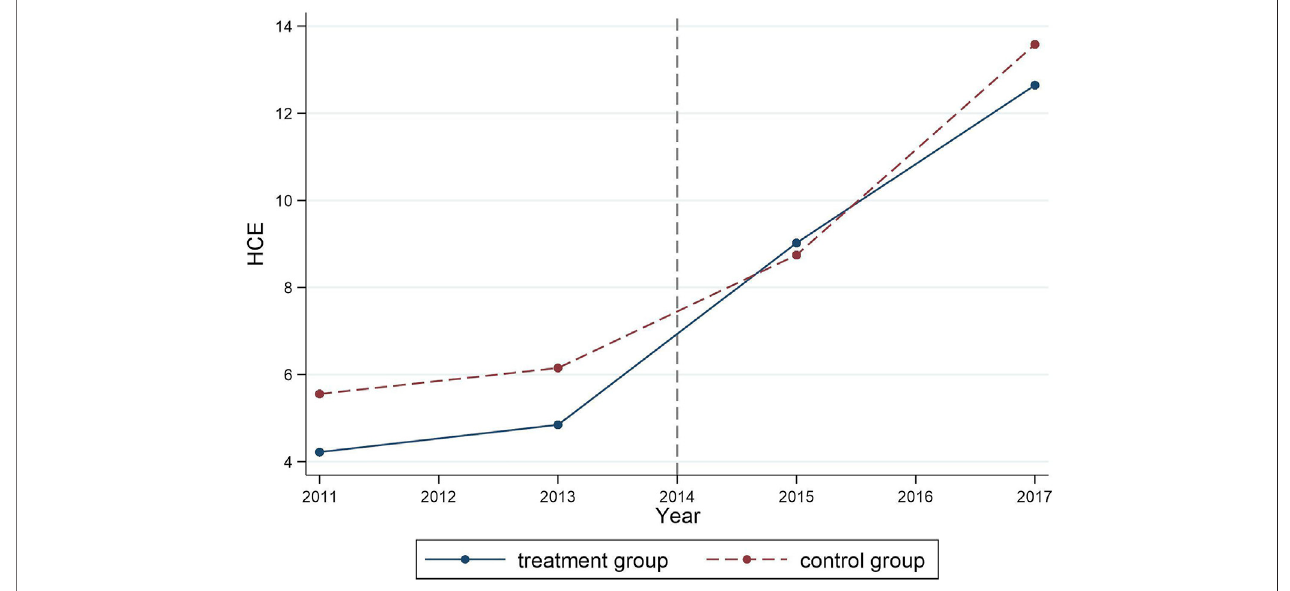
FIGURE 5 | Dynamic effects of the B and V on rural